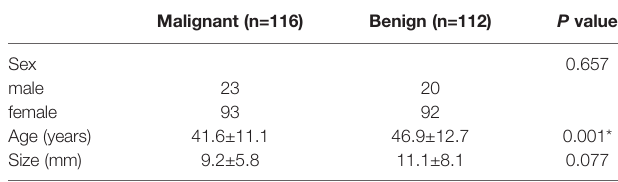
TABLE 1 | Basic characteristics of the included nodules (n=228).